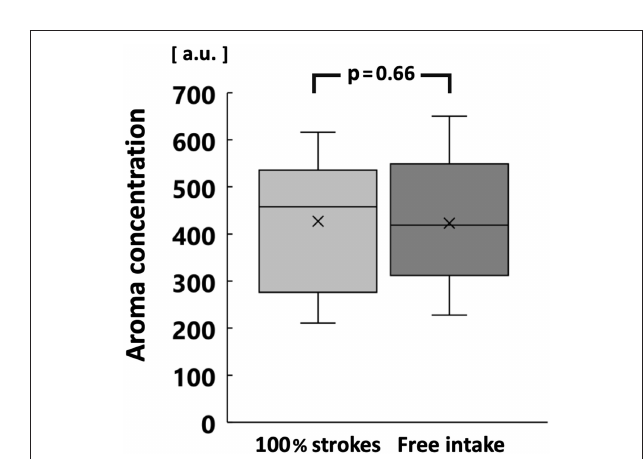
FIGURE 7 | Comparison of maximum aroma concentration between chewing strokes equal to 100% of swallowing threshold and free intake. No significant difference was